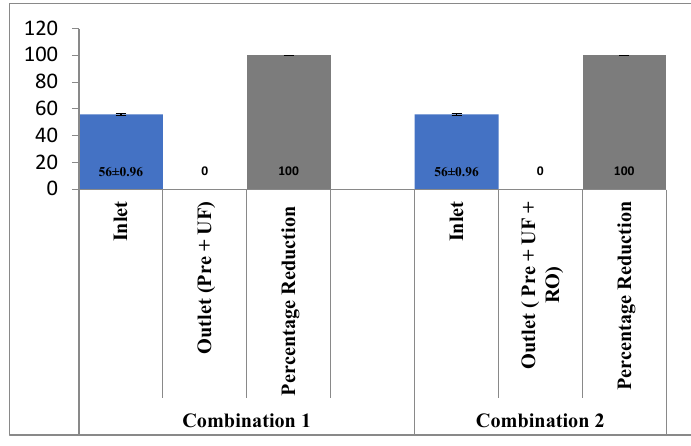
Figure 4. Effect of different treatment setups on the TSS rejection .